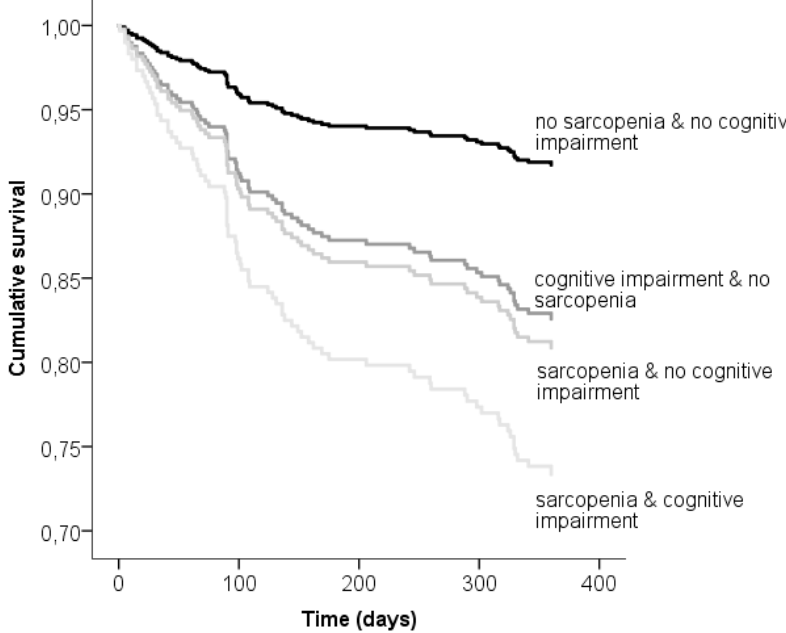
Figure 1. Kaplan–Meier curves showing survival according to the presence of cognitive impairment, sarcopenia or combined sarcopenia and cognitive impairment.